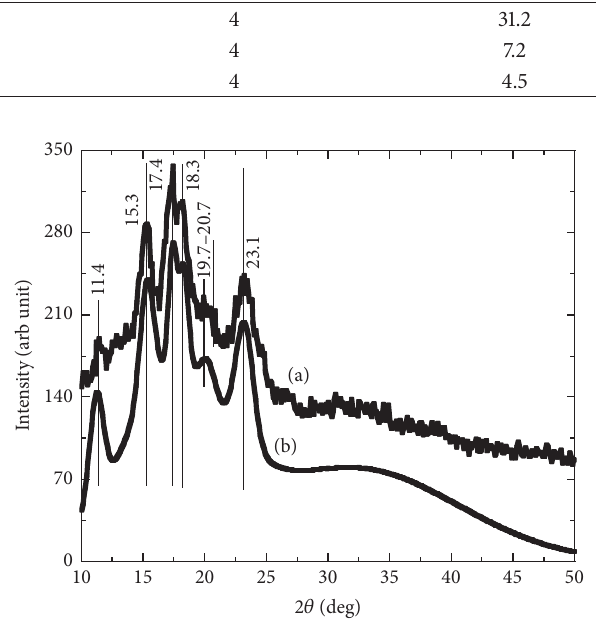
Figure 1: The diffractogram of pure starch before heating (a), and the simulation of the main peaks (b). The graphs were separated on the vertical axis by 50 arb unit for better